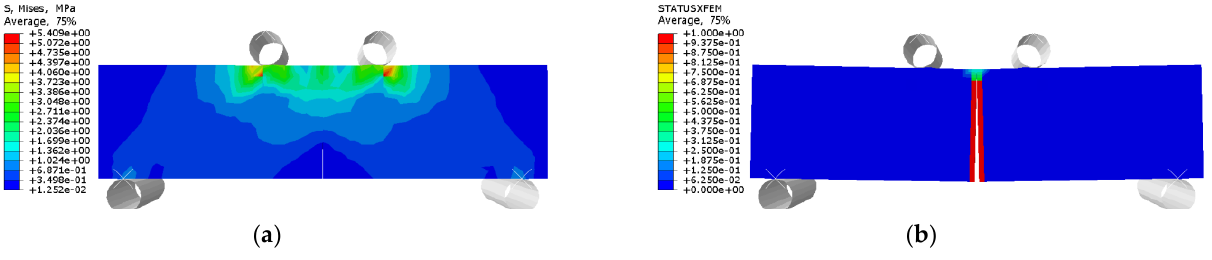
Figure 39. URFSF-100: ( a ) stress nephogram and ( b ) damage nephogram of prefabricated crack.